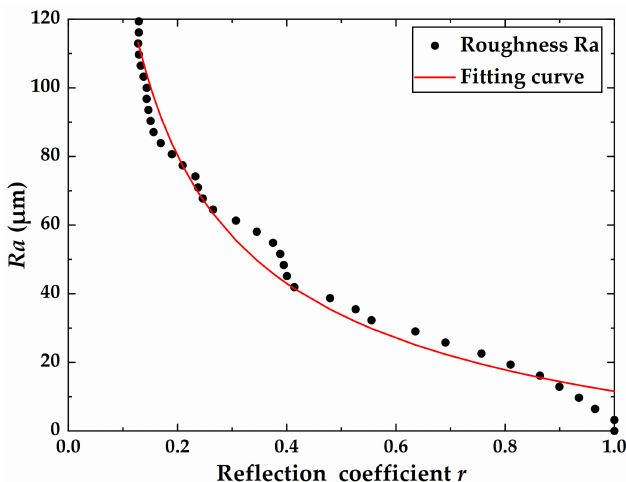
Figure 13. Corresponding relationship between roughness Ra and echo reflection coefficient r ; beads’ contact angle is 30 ◦ and beads’ height is in the range of [0, 370] µ